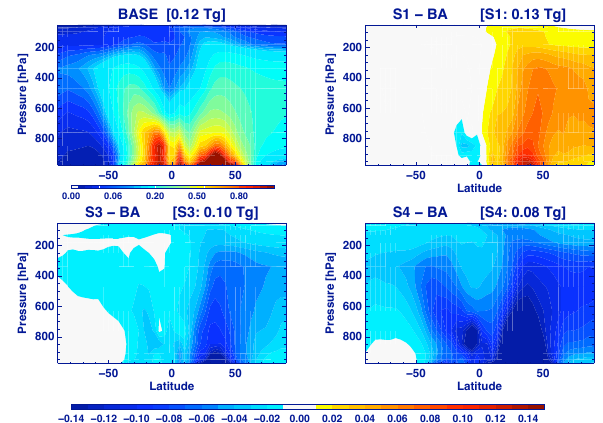
Fig. 2. Zonal mean BC mass mixing [µg/kg] ratios for the BASE case and the differences between BASE (BA) and the size experi- ments, S1, S3, and S4. Global mean BC mass concentrations per Figure 2 Zonal mean BC mass mixing [ µ g/kg] ratios for the BASE case and the differences between experiment are given in the figure BASE (BA) and the size experiments, S1, S3, and S4. Global mean BC mass concentrations per experiment are given in the figure titles.